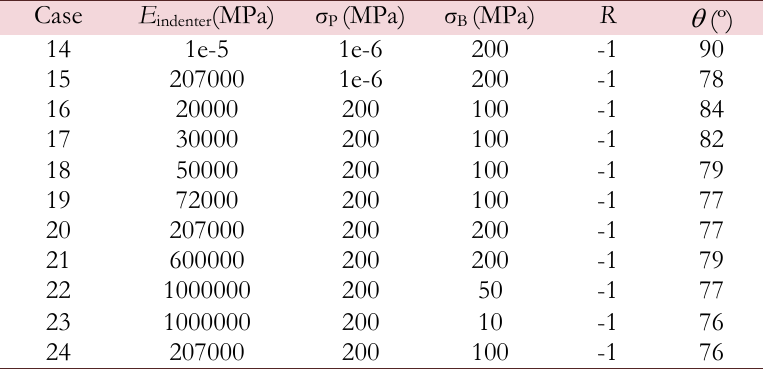
Table 2: Predicted orientation angles for different material stiffness of the indenter and some variations of  P and  Bulk .